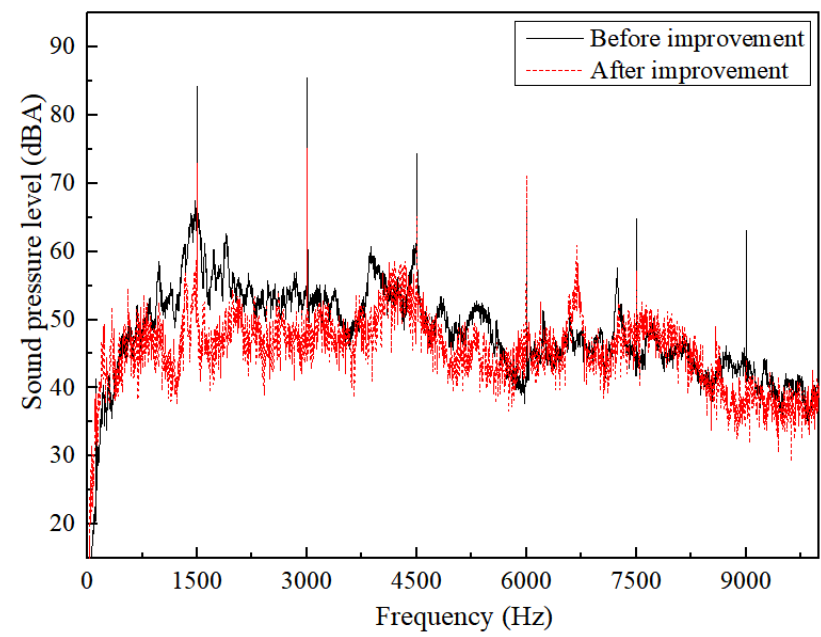
Figure 22. Noise characteristics before and after